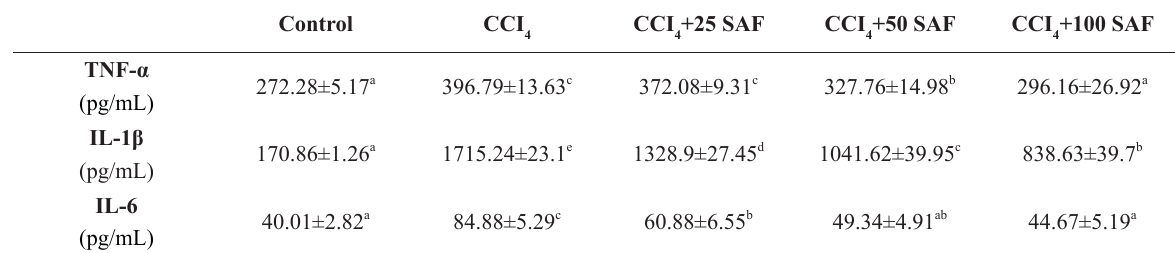
Serum inflammation markers (IL-1β, IL-6, TNF-α).